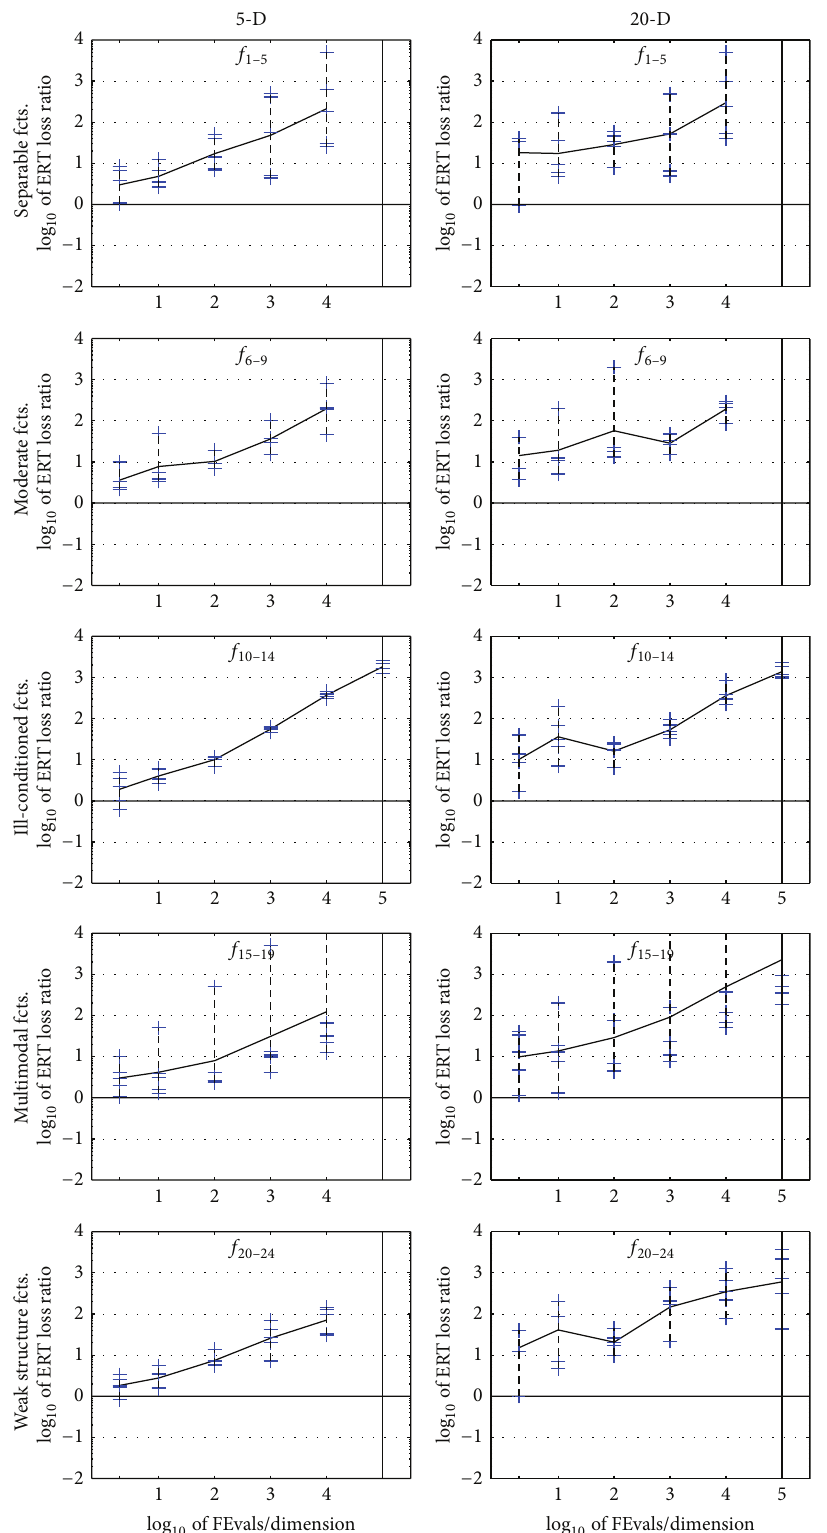
Figure 3: ERT loss ratios (see Table 2 for details). Each cross (+) represents a single function and the line is the geometric